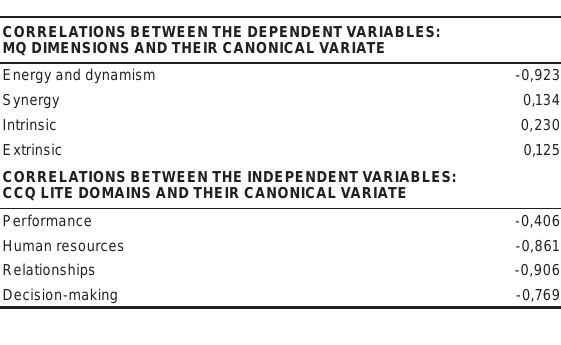
Table 12 Correlations between drivers for corporate culture and job satisfaction for high and low groups on energy and dynamism